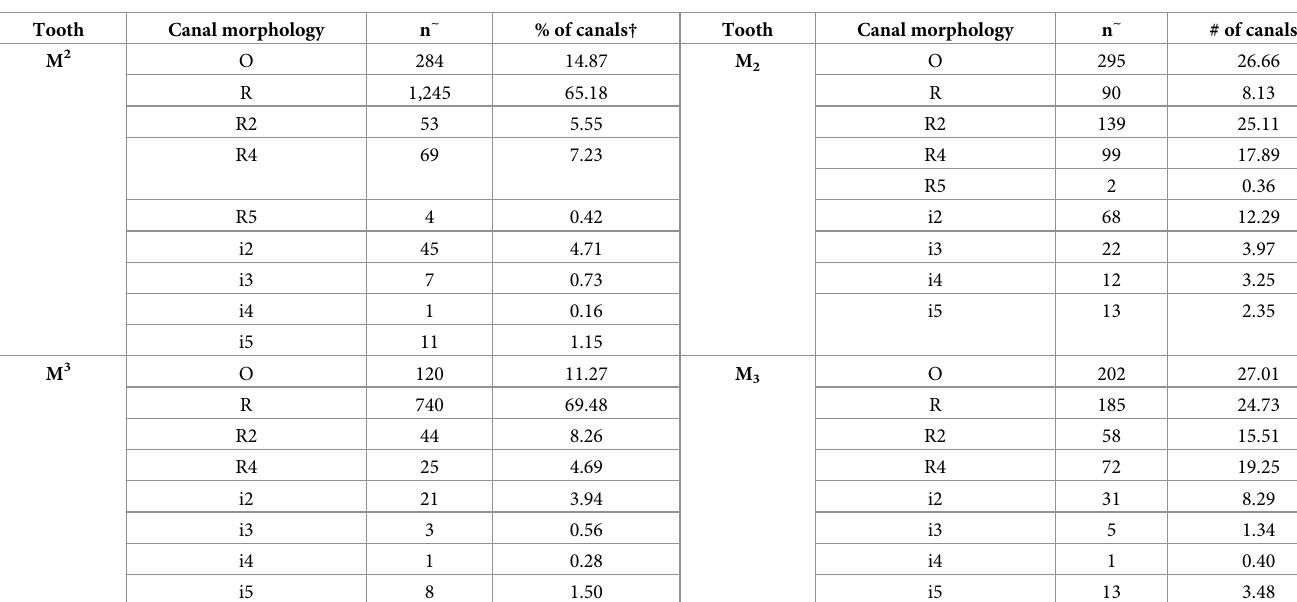
† = Table 4. Congenitally absent teeth not included in statistics for this table.